Question: Summarize what this figure shows in one sentence.
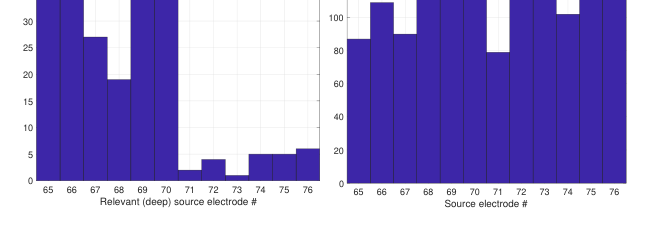
Answer: Left: Histogram of the selected relevant sources using a hidden redundancy process. Only hidden redundancy processes and relevant source processes that are causally coupled to the targets 6 – 8 and 14 – 16 are considered. Right: Histogram of T in (17), i.e., the 80% greatest coupled sources to the targets without using a hidden redundancy process.